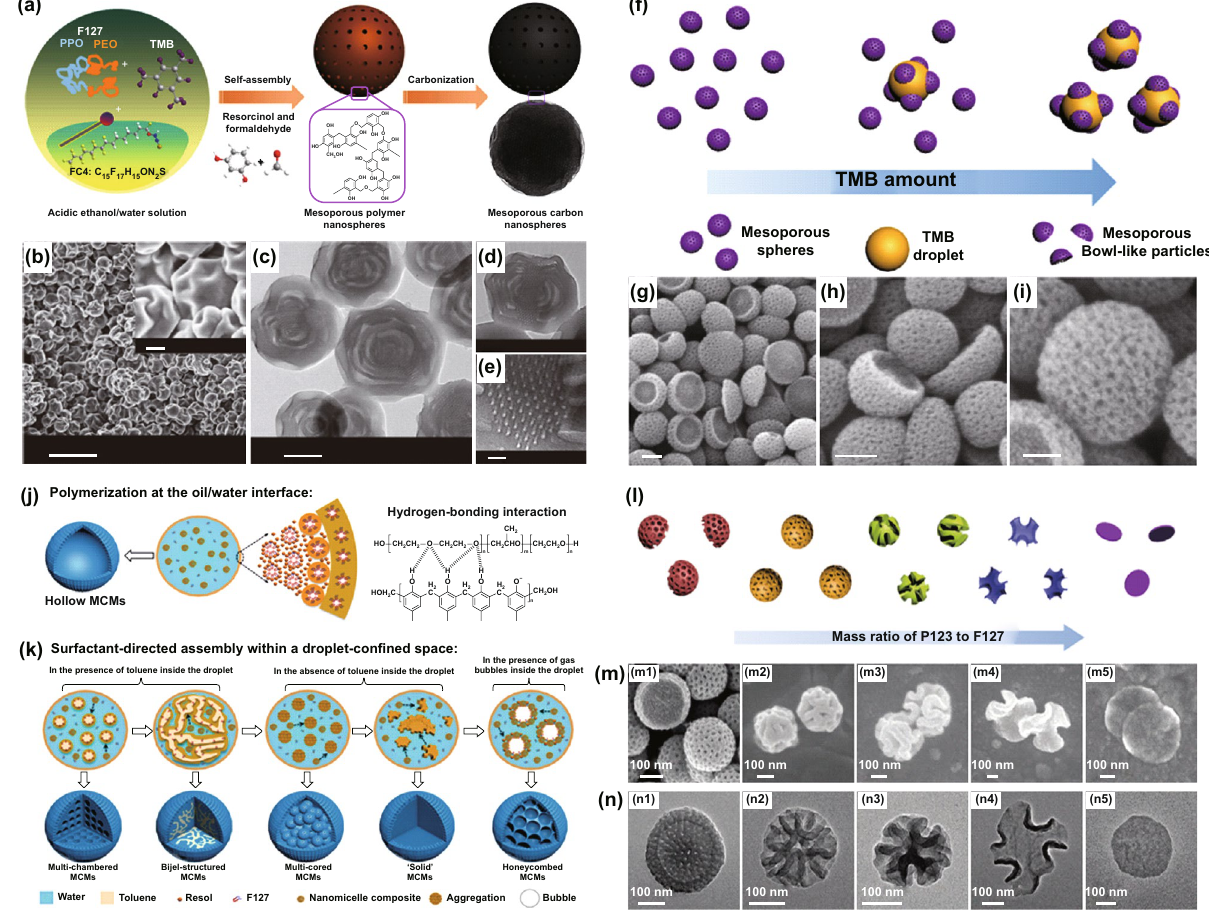
Fig. 4 a Schematic illustration of the formation process of MCNs. b SEM images, c , d TEM images, and e HRTEM image of MCNs. Repro- duced with permission from Ref. [65]. Copyright 2013, Nature Publishing Group. f Schematic representation of the mesoporous PDA particle formation. g–i FESEM images of the as-synthesized bowl-like hollow carbon particles. Reproduced with permission from Ref. [66]. Copyright 2016, American Chemical Society. Schematic illustration of j interfacial polymerization of phenolic resol in the presence of Pluronic F127, and k evolution of the interior structures. Reproduced with permission from Ref. [67]. Copyright 2018, Wiley–VCH. l Schematic representation, m FESEM (top), and n TEM (bottom) images of mesophase transition PDA particles with different mass ratios of P123 to F123. Reproduced with permission from Ref. [68]. Copyright 2018, Wiley–VCH. Scale bars are b 1 mm (inset image: 100 nm), c 200 nm, d , g , h 100 nm, e 10 nm,